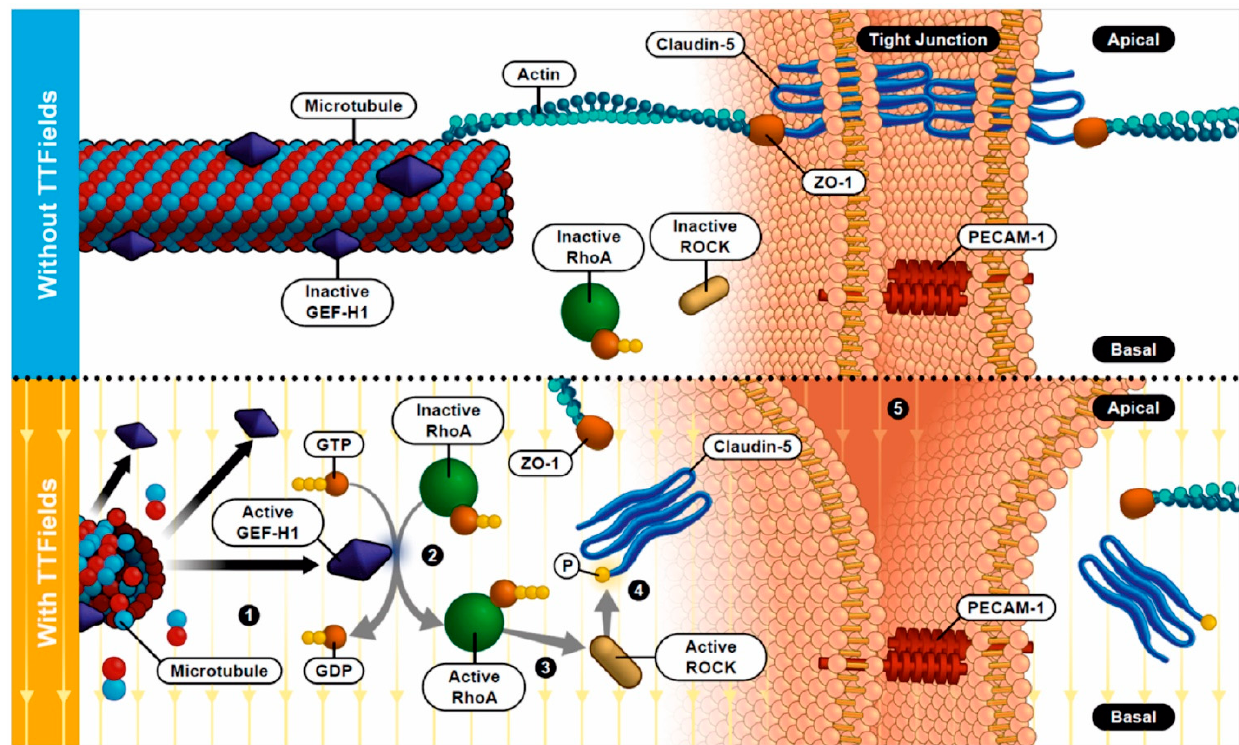
Figure 7. Scheme of the putative TTFields’ mode of action for opening the BBB. Without TTFields, claudin-5 forms tight junctions between the brain vascular endothelial cells and is connected via ZO-1 to the actin cytoskeleton (upper). With the use of TTFields, (1) microtubule organization is altered, activating GEF-H1. This leads to (2) increased levels of RhoA which, in turn, (3) activates ROCK resulting in (4) claudin-5 phosphorylation. Due to this, claudin-5 anchorage to ZO-1 is disrupted, causing claudin-5 to be delocalized from the cell membrane to the cytoplasm, thus (5) weakening the tight junctions